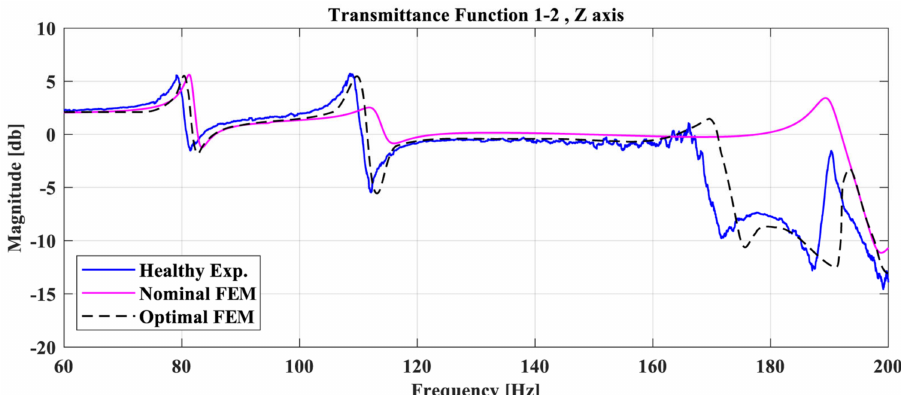
Figure 6. Comparison of TF between accelerometers 1,2 (Z‑axis) between the Healthy experimental structure, the Nominal FE model, and the Optimal FE model.